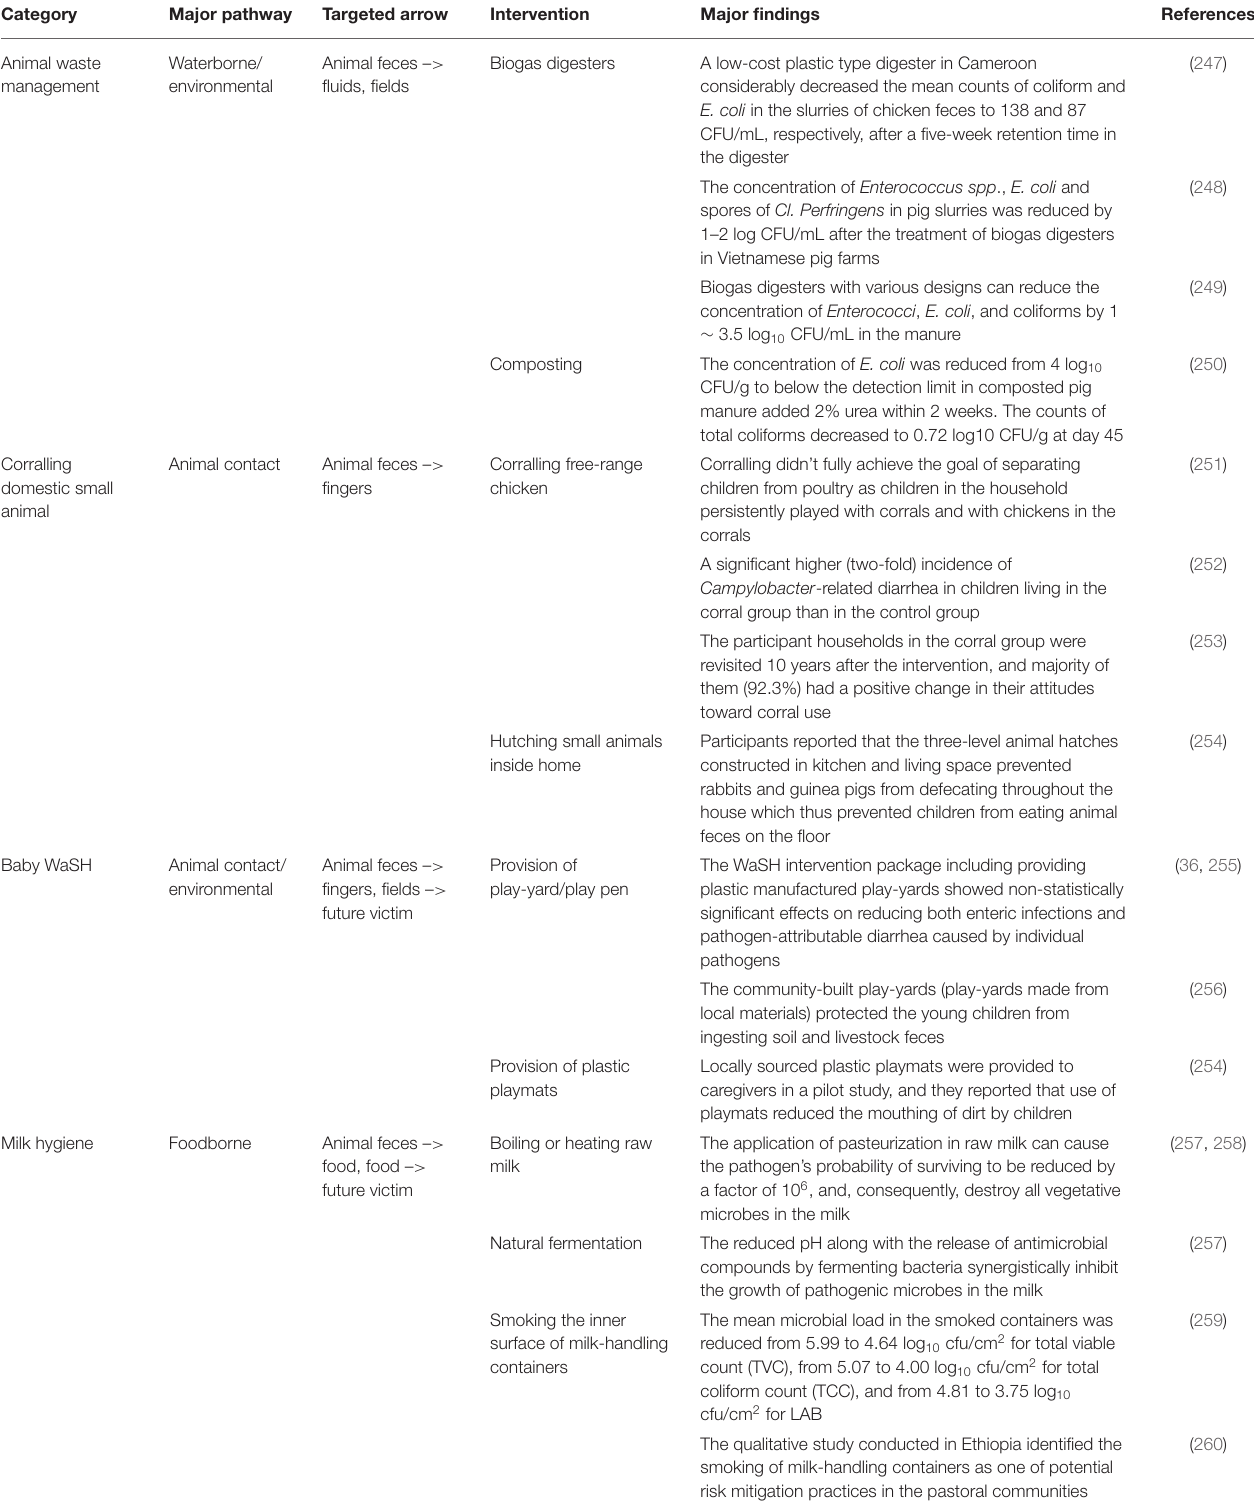
TABLE 8 | Control measures to prevent exposure to animal feces in